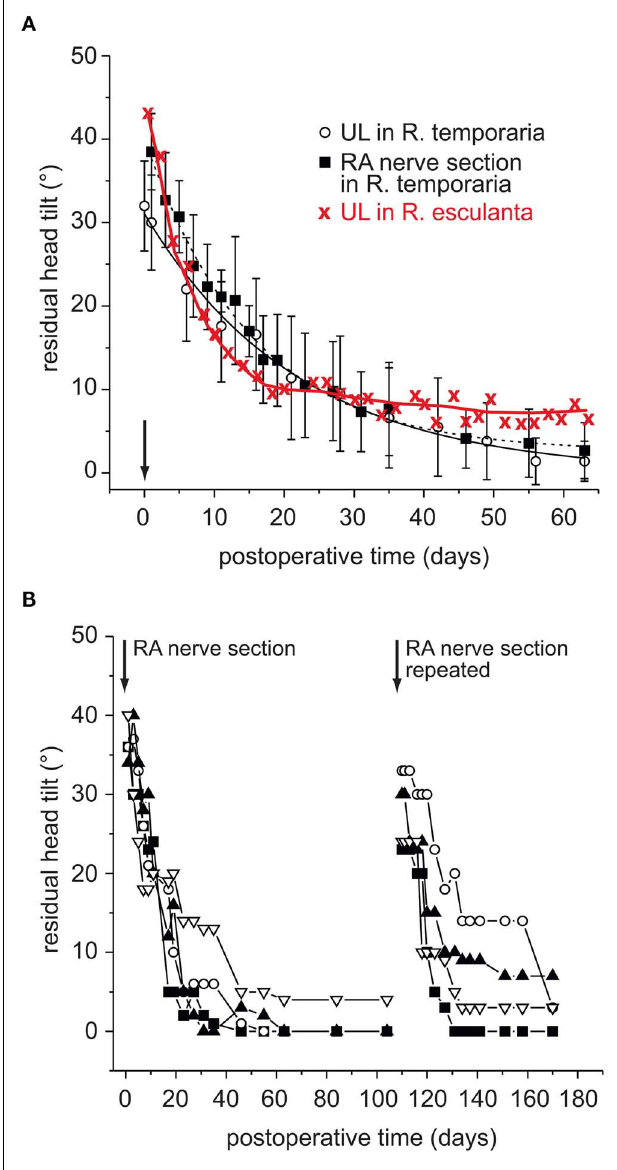
FIGURE 4 |Time course of recovery from the postural asymmetry after a unilateral vestibular lesion in adult frog. (A) Angle of the head roll tilt as a function of postoperative time in grass frog ( Rana temporaria ) after UL or selective section of the anteriorVIIIth nerve branch (RA) and in water frog ( Rana esculenta ) after UL; data on UL in Rana esculenta adopted from Kolb (1955) and in Rana temporaria from Flohr et al. (1981). (B) Comparison of the residual head tilt angles in four specimen of Rana temporaria in which the same RA nerve branch was re-sectioned 100days after the first lesion; modified and adopted from Goto et al.